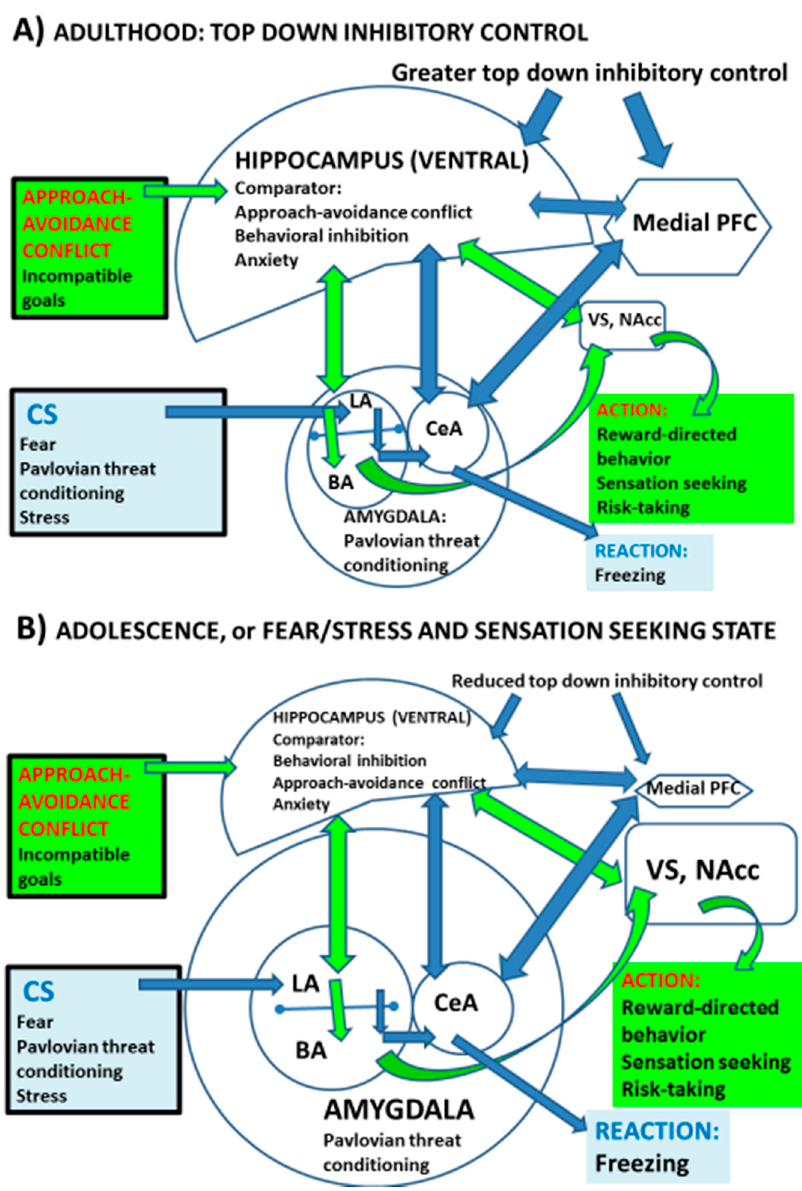
Figure 1. Proposed “tetradic” model of interactions and connectivity among fear/threat (AMY)- and reward (VS)-related circuitry and the degree (indicated by the size of the structures) of top-down inhibitory control by the vHPC and mPFC on AMY and VS (NAcc), which seems to be optimal during adulthood ( A ) and decreased during adolescence ( B ), one of the likely reasons being that the vHPC and mPFC (and at least part of their related circuitry/connectivity) mature later than the other two regions. This would imply that during adolescence ( B ), both threat reactions and reward-linked processes or actions would be simultaneously facilitated. CS; aversive conditioned stimulus. LA; lateral amygdala; BA; basal amygdala. CeA; central amygdala. Other symbols as in the text. Based on Fernandez-Teruel and Tobeña, 2020 [9] and references therein.